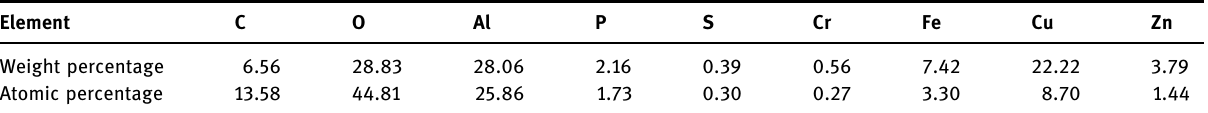
Table 9: Element analyses of corrosion products of aluminium alloy 6061 after corrosion by saturated Ca ( OH ) 2 solution ( % ) Element